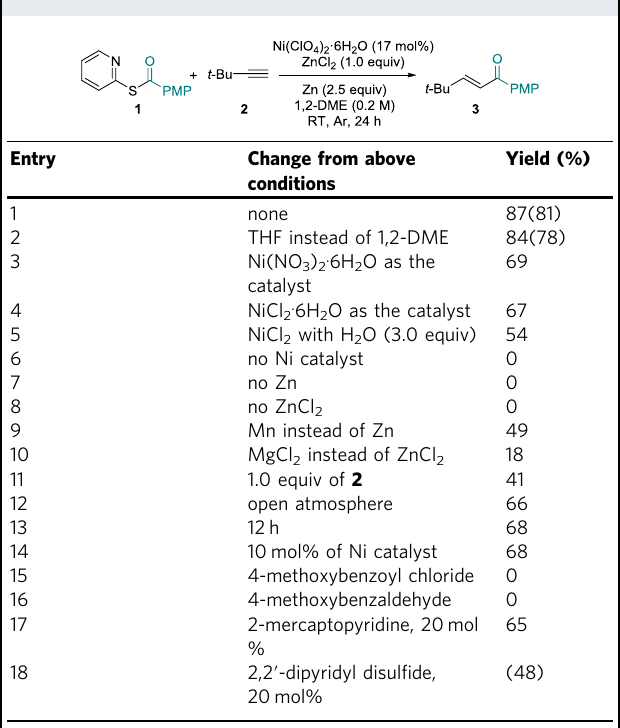
Table 1 Reaction